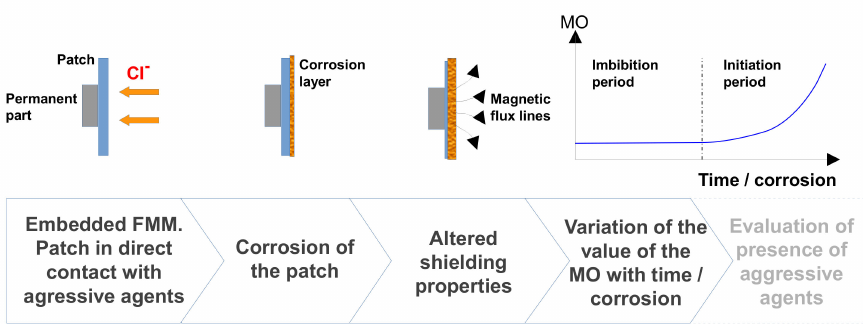
Figure 2. Flow chart of the principle of the FMM.